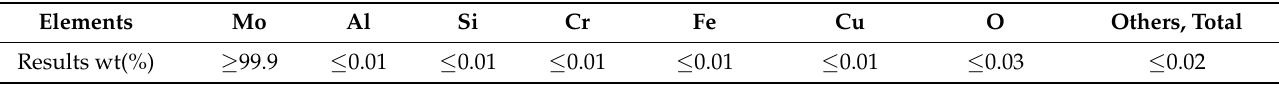
Figure 1. SEM micrograph of molybdenum powder: ( a ) spheroidized powder, ( b ) polygon powder. Table 1. The chemical composition of spheroidized Mo powder.